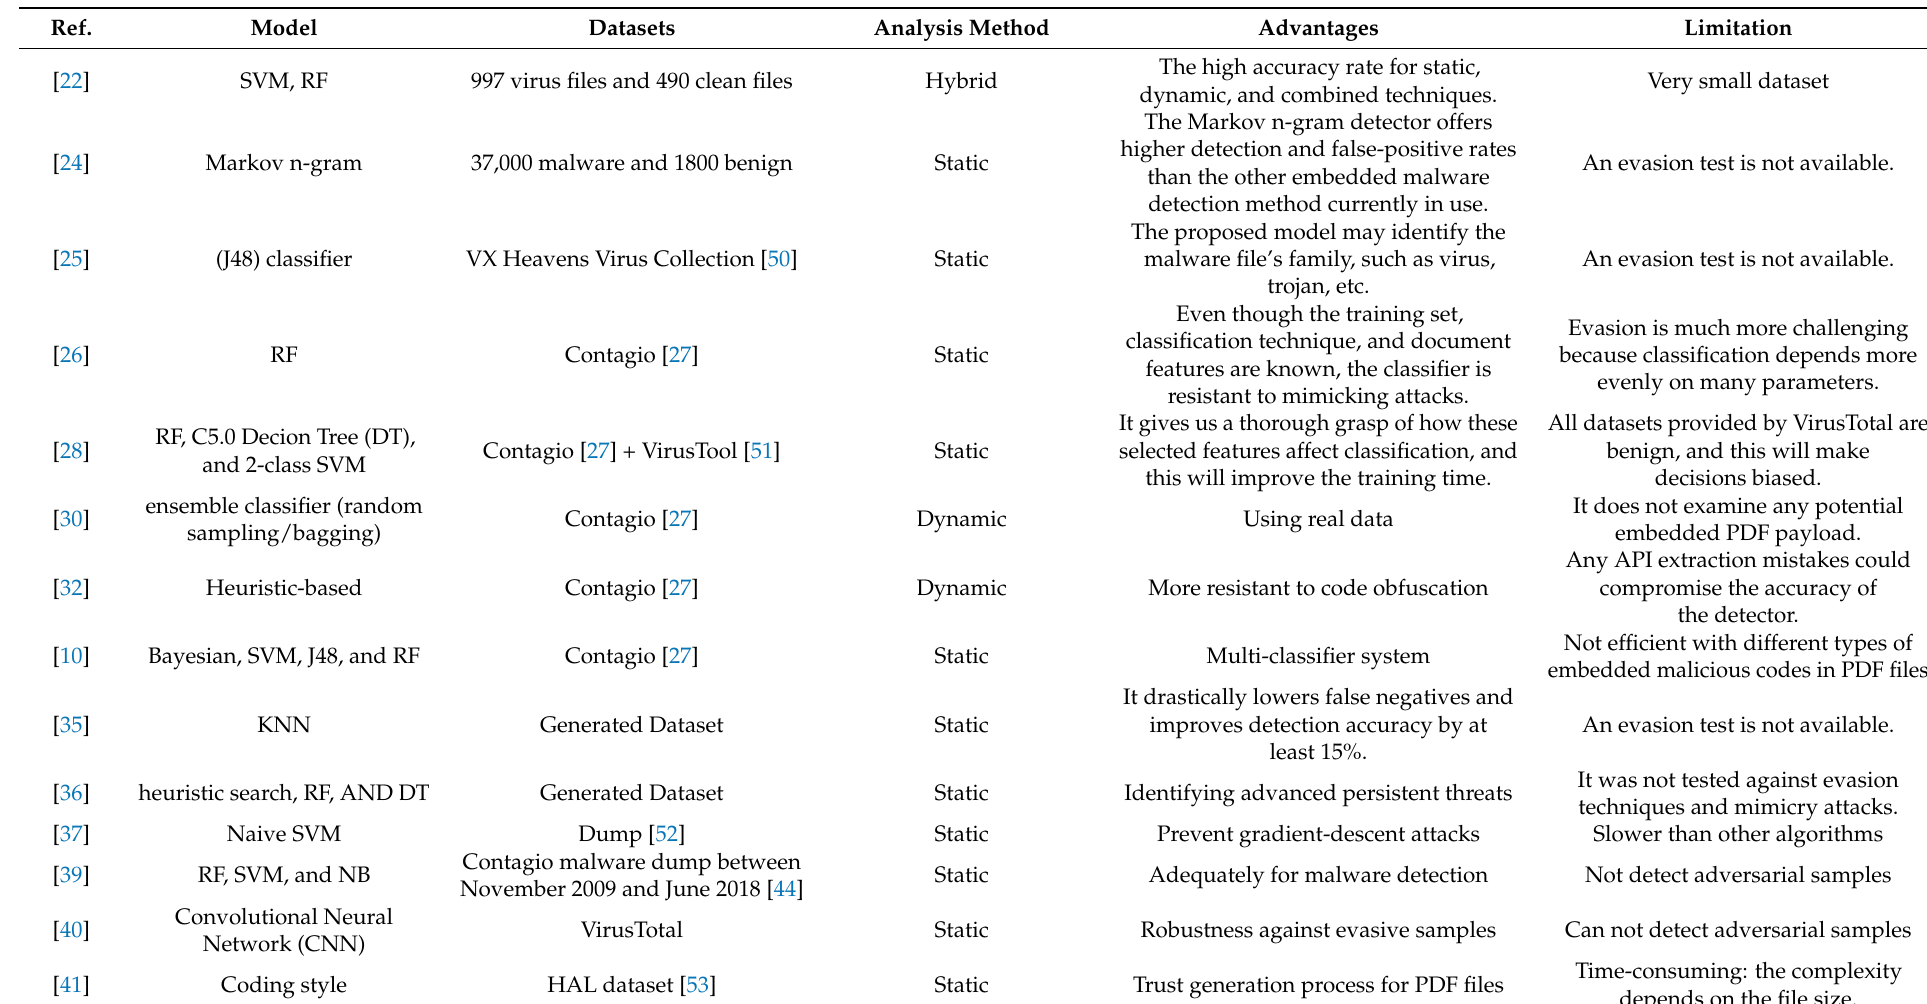
Table 1. Summary of reviewed related